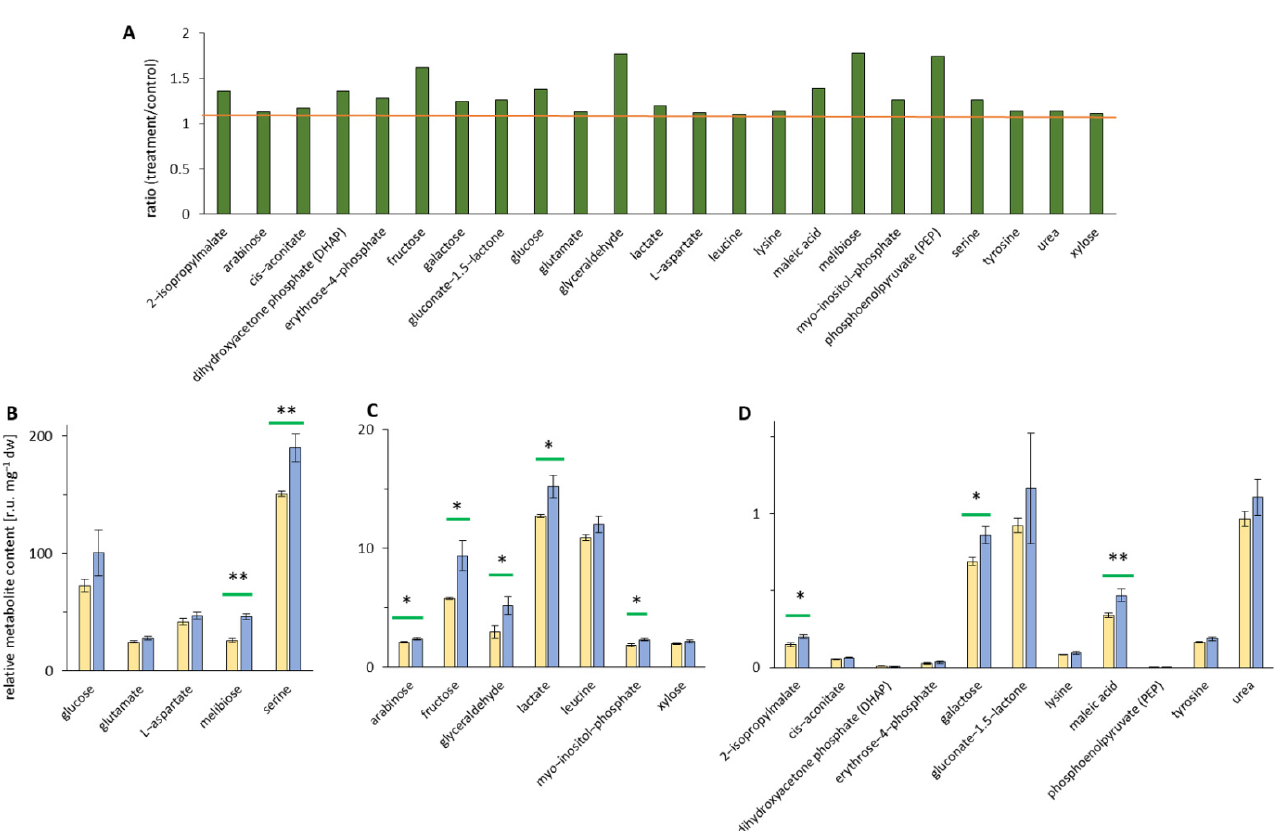
Figure 5. Metabolomic changes in Arabidopsis thaliana leaves represented as ratio of treatment/control >1.1. Metabolite levels of treatment and control extracts were measured using GC–MS in leaves from 30-day-old plants after 48 h of EMF irradiation. Control samples are given in yellow, and the treated samples are in blue. ( A ) Overview of increased ratio of the relative metabolite content between treated and control extract metabolites (>1.1, orange bar). ( B ) Upregulated high relative metabolite content [r.u. mg − 1 dry weight]. ( C ) Upregulated intermediate relative metabolite content [r.u. mg − 1 dry weight]. ( D ) Upregulated low relative metabolite content [r.u. mg − 1 dry weight]. Independent experiments = 3, n = 6, means ± SE, Student’s t -test, p < 0.01 **, and p < 0.05 *, indicated by green bars.